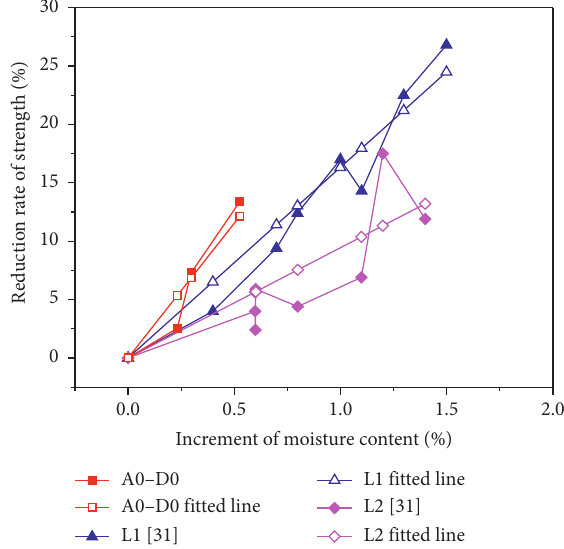
Figure 8: Influence of moisture content increment on static re- duction rate of strength.